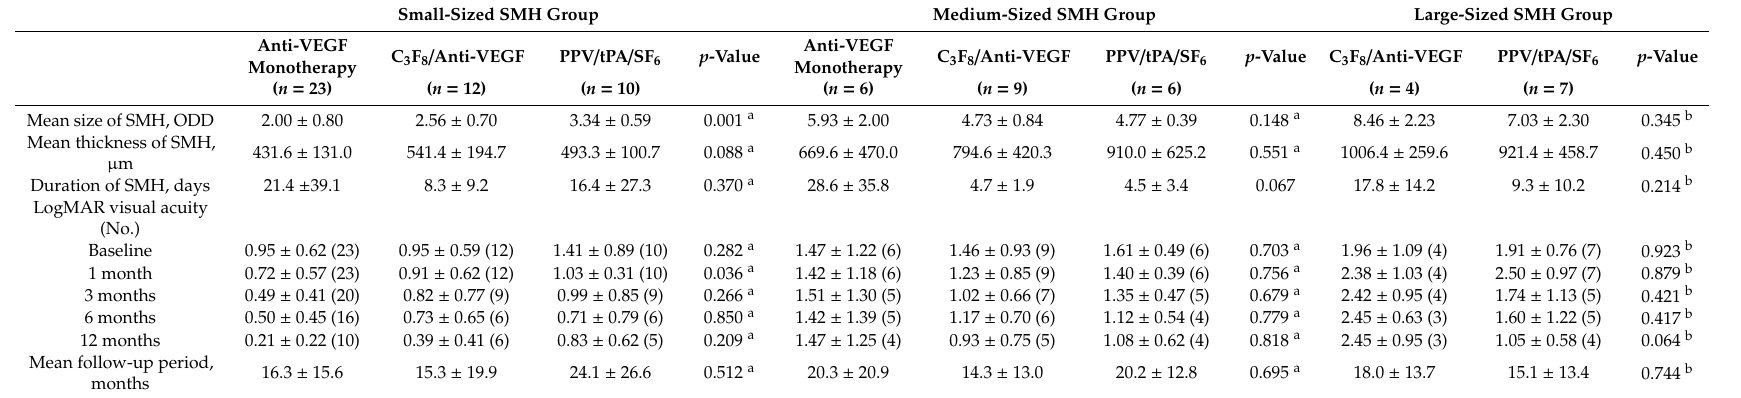
Table 3. Subgroup analysis of treatment outcomes based on SMH